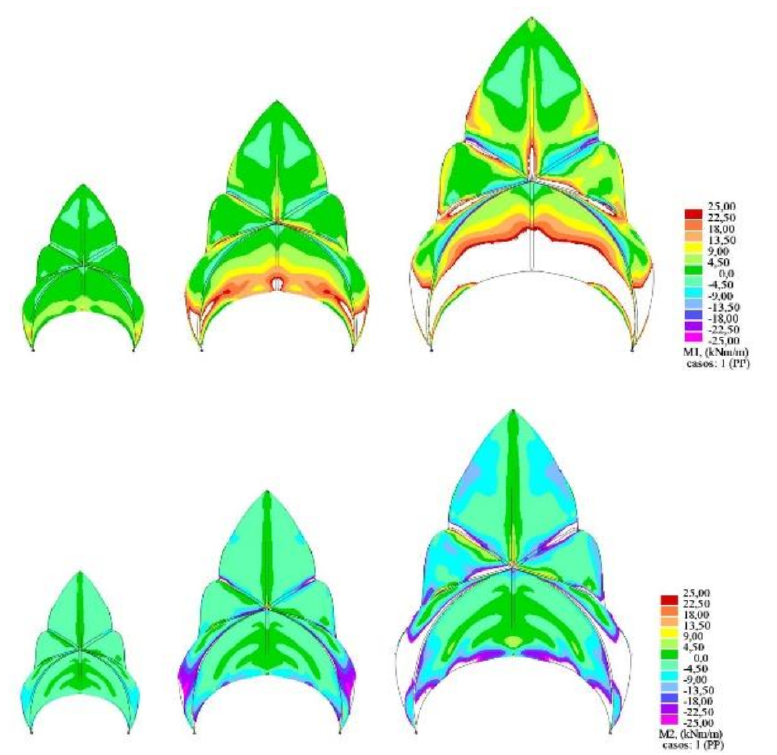
Figure 18. Principal bending moments M1 ( top ) and M2 ( bottom ). Load case: